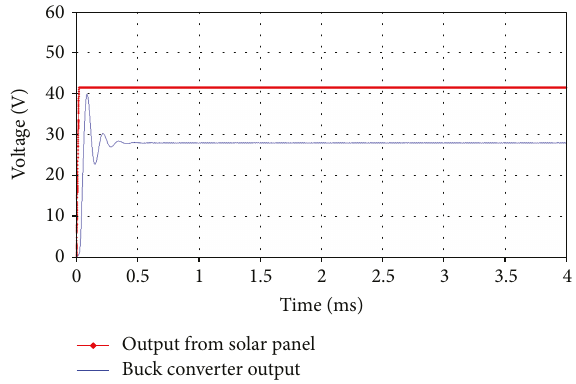
Figure 16: Input and output voltage waveforms for 41V input.